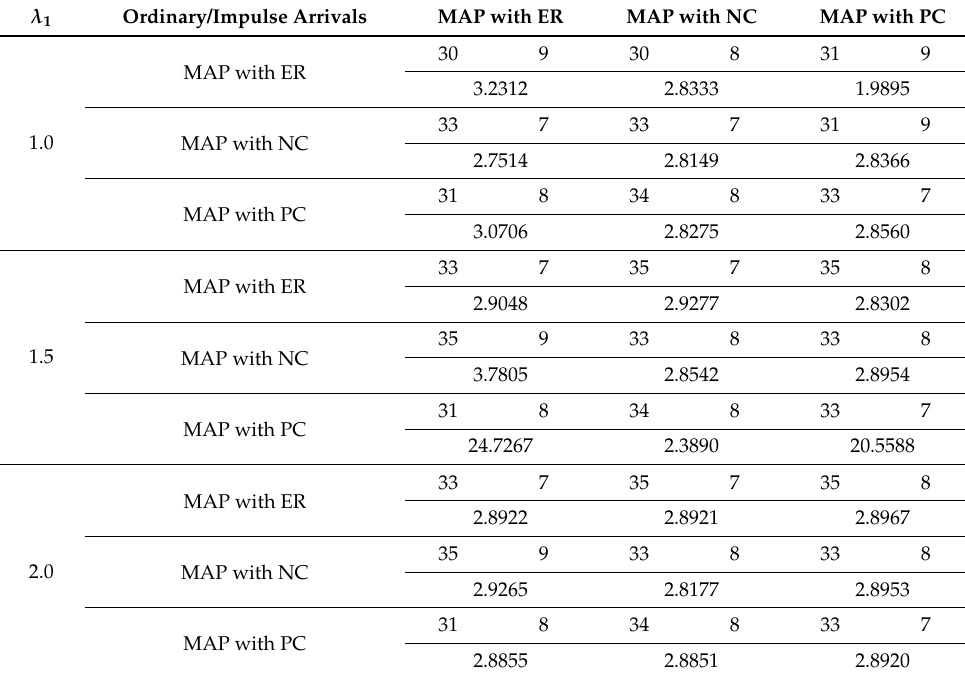
Table 10. Effects of λ 1 with various MAP.